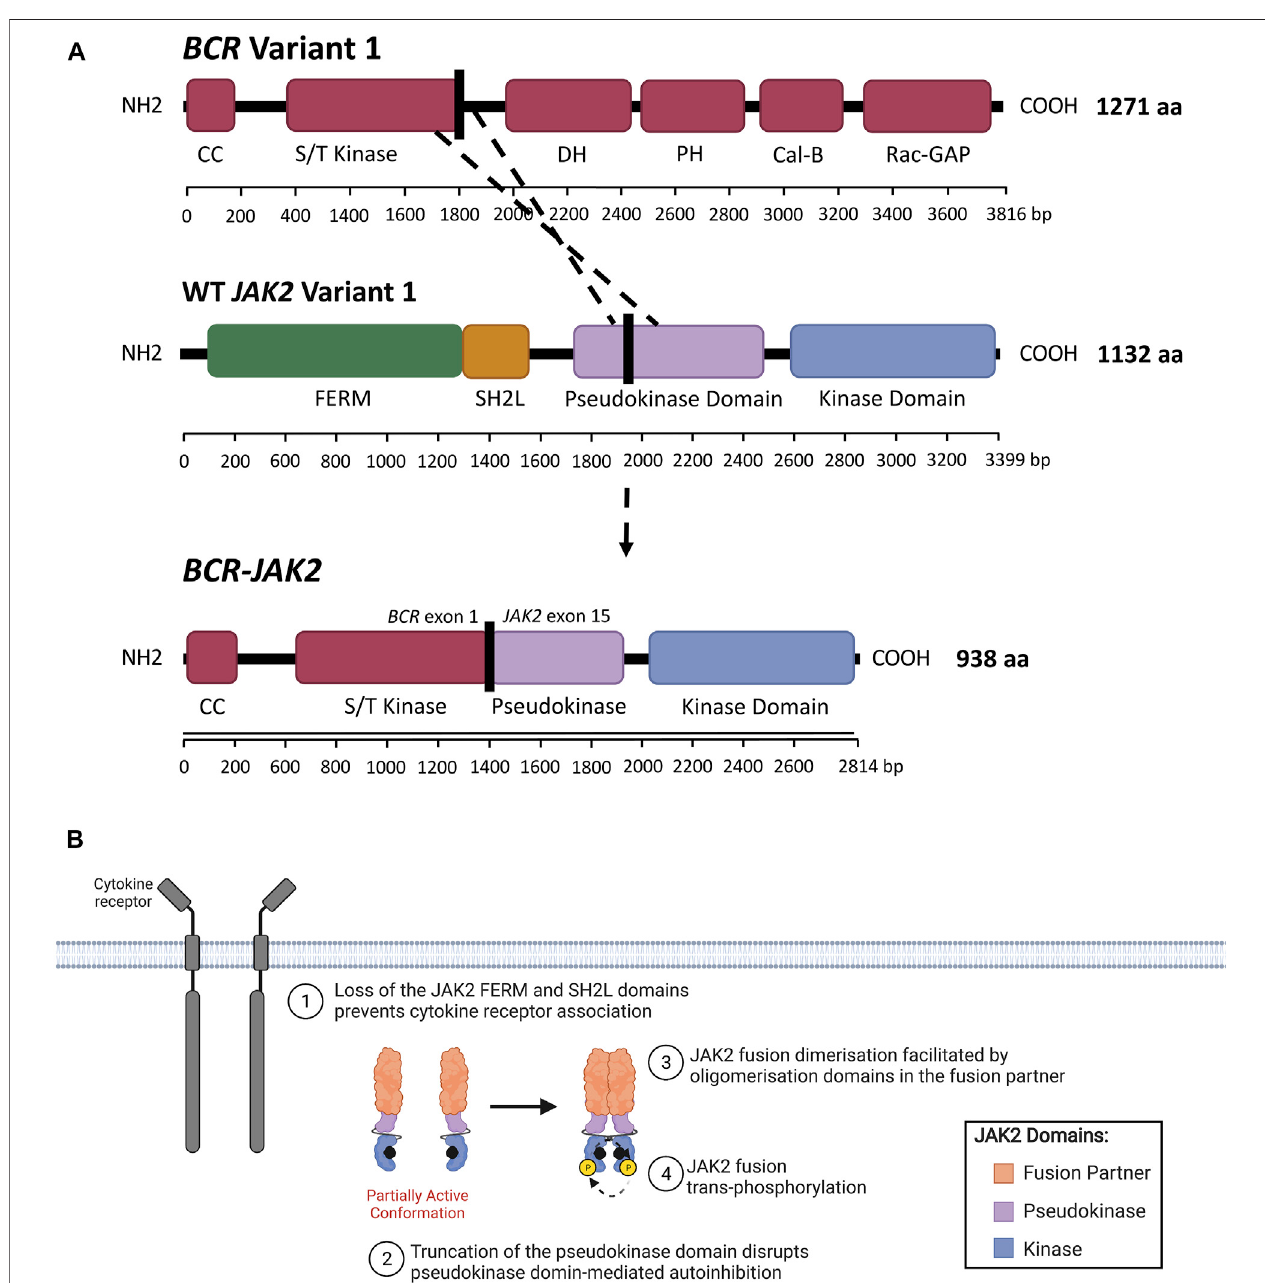
FIGURE 5 | JAK2 fusion proteins in ALL. (A) Schematic representation of a genomic rearrangement between JAK2 exon 15 and BCR exon 1 that produces the BCR-JAK2 fusion gene. BCR isoform 1 (encoded by BCR variant 1) contains the following domains: BCR coiled-coil (CC), serine/threonine kinase (S/T kinase), DH (Dbl homology), PH (pleckstrin homology), Cal-B (calcium-dependent lipid-binding) and Rac-GAP (Rac GTPase-activating protein) domains. The BCR DH and PH domains form the Rho-GEF domain (Rho guanine nucleotide exchange factor). JAK2 isoform A (encoded by JAK2 variant 1) contains FERM (4.1 protein, ezrin, radixin, moesin), SH2-like (SH2L, Src homology 2), pseudokinase (JH2) and kinase (JH1) domains. The BCR-JAK2 fusion protein retains the BCR CC and S/T kinase domains, threeexonsoftheJAK2pseudokinasedomainandthefull-lengthJAK2kinasedomain.BCR-JAK2ispredictedtohomodimeriseviaitsretainedBCRCCmotif.Domains encoded by the BCR , JAK2 and BCR-JAK2 transcripts were annotated using InterPro (EMBL-EBI, 2021) (Jones et al., 2014; Blum et al., 2021) and Maru amd Witte (1991). (B) SchematicrepresentationofJAK/STATsignalingpathwayactivationthroughJAK2fusions.AllJAK2fusionscompriseofanN-terminalfusionpartner(orange) and the full-length JAK2 kinase domain (JH1, blue). The full-length or truncated JAK2 pseudokinase domain (JH2, purple) may also be present or absent in different JAK2 fusions. The absence of the JAK2 FERM and SH2-like domains prevent JAK2 fusions from associating with the cytoplasmic juxtamembrane motifs of cytokine receptors (dark grey). JAK2 fusions are shown bound to ATP (black). The proposed model of JAK2 fusion activation suggests that oligomerization domains within the fusion partner may facilitate JAK2 fusion dimerisation and subsequent trans -phosphorylation, promoting malignant transformation. Adapted from “ Cytokine Signaling through the JAK-STAT Pathway ” (BioRender.com, 2021).